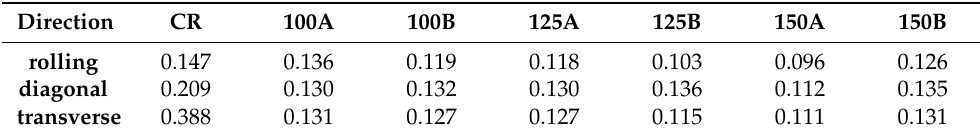
Table 3. Strain-hardening exponent n of plastic deformation for cryogenic rolled AA6061 in different heat treatment